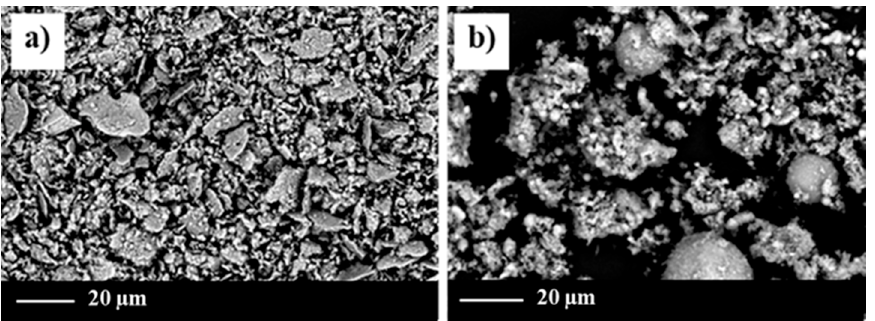
Figure 2. SEM images of ( a ) metakaolin and ( b ) biomass ash.